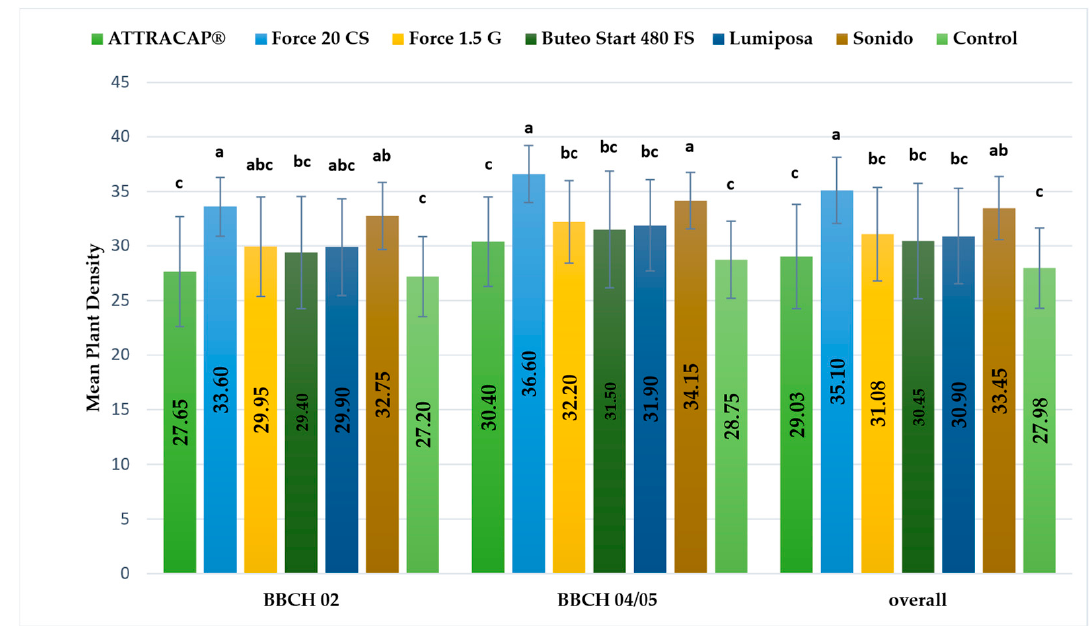
Figure 4. Plant density depending on the insecticidal treatment at RŠ T-12 in 2021.